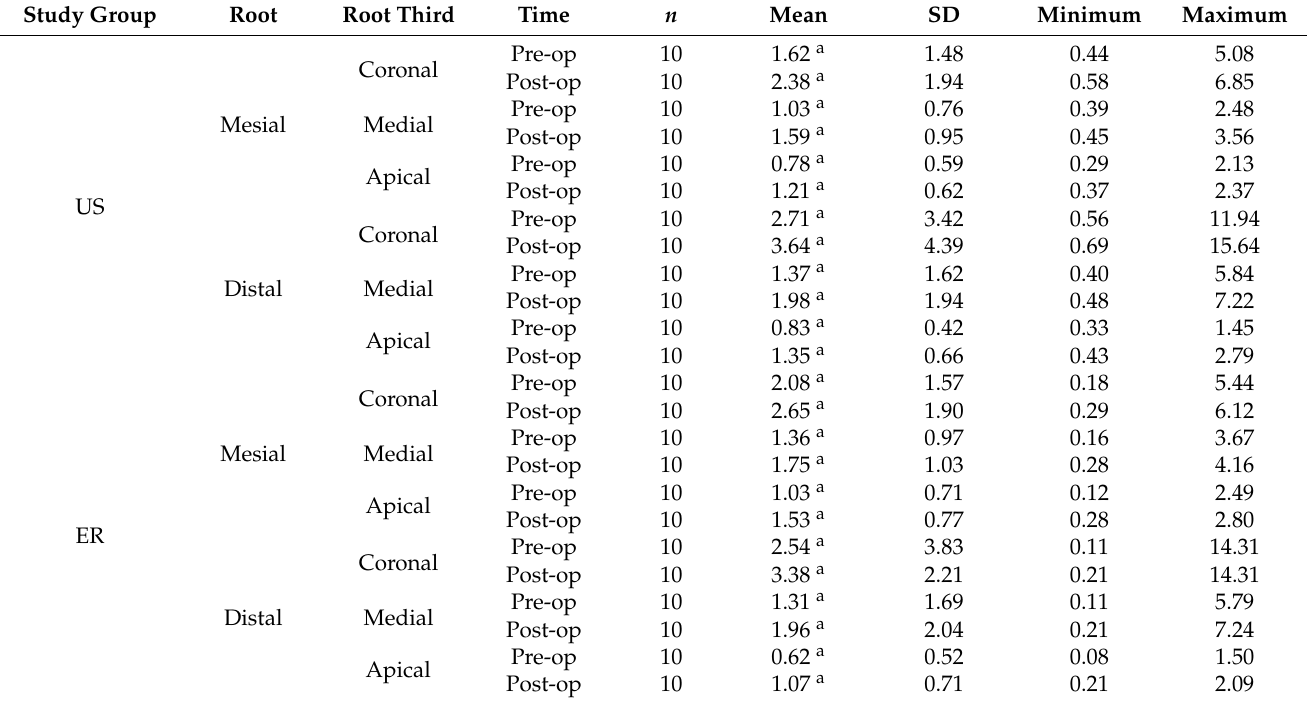
Table 1. Descriptive values of the preoperative and postoperative volumetric differences (mm 3 ) between the US and ER study groups at the coronal, medial, and apical